Question: Condense the content of this figure into a single sentence.
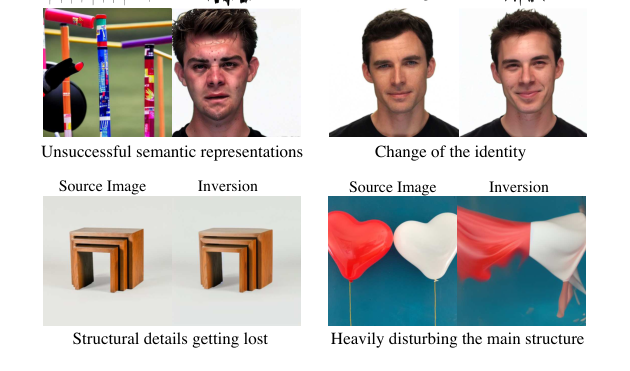
Answer: Limitations of the SonicDiffusion model. The figure illustrates various scenarios where the SonicDiffusion model does not adequately perform in the generation or modification of images based on audio cues. Issues arise from imprecise semantic interpretations of audio signals, as well as from artifacts introduced during the Stable Diffusion process. In the context of image editing, our model may inadvertently replace original content, conduct ineffective semantic modifications, or alter the subject’s identity. Notably, some of the editing challenges are attributed to the use of DDIM inversion, which can result in the insertion of extraneous elements, the omission of fine details, or significant structural disruptions.